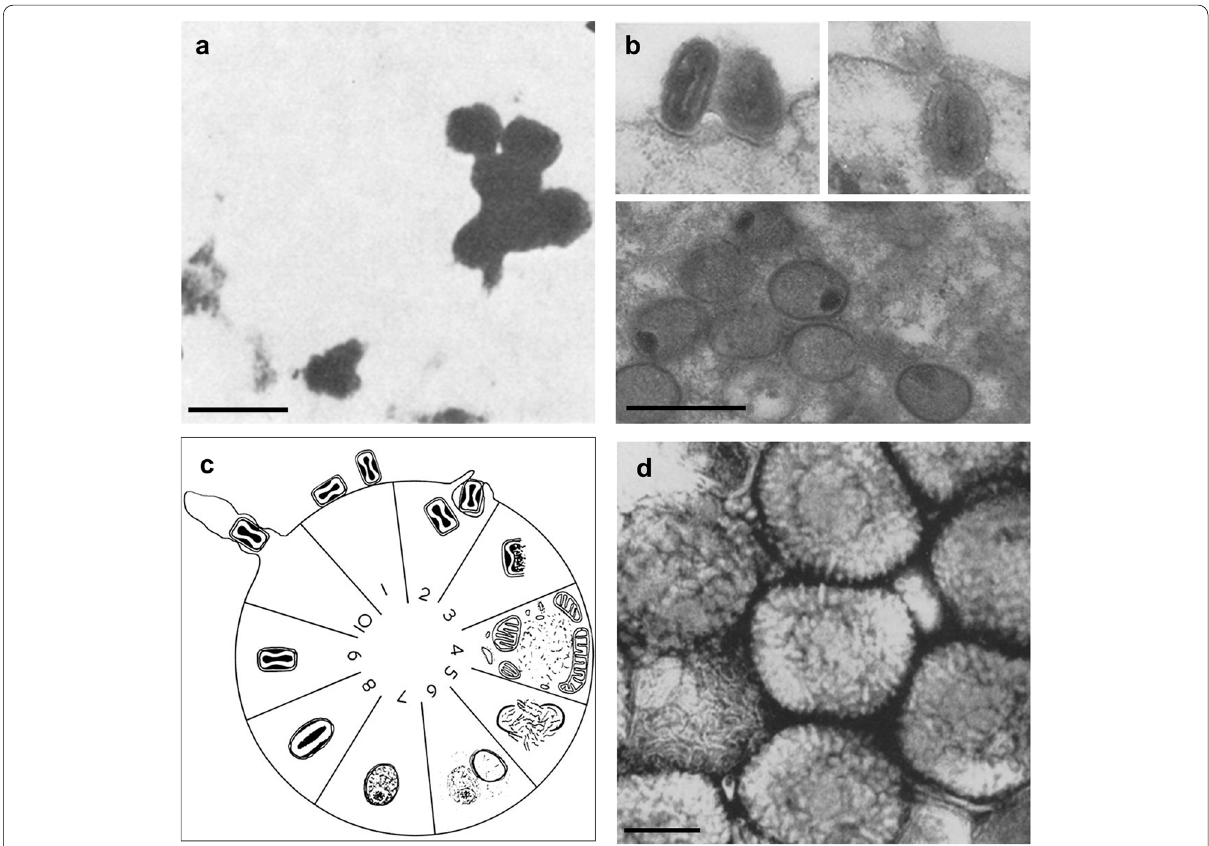
Fig. 1 Early TEM examinations of VACV and proposed virion assembly. a Brick-shaped morphology of VACV “elementary bodies” first described by Ruska in 1939. b Thin-section TEM images of VACV mature virions (top row) and immature virions containing nucleoids (bottom row). c VACV assembly cycle as proposed by Dales, showing schematic illustration of virion morphology and post-infection time in hours. d TEM image of negatively stained whole VACV mature virion exhibiting characteristic surface tubule decoration. Scale bars are 0.5 μm in ( a ) and ( b ), and 0.1 μm in ( d ). The images are reprinted with permission. Original works are from a Ruska et al., Archiv für die gesamte Virusforschung, 1939, doi: https:// doi. org/ 10. 1007/ BF012 43399, b , c Dales and Siminovitch, The Journal of Biophysical and Biochemical Cytology, 1961, doi: https:// doi. org/ 10. 1083/ jcb. 10.4. 475, d Dales, The Journal of Cell Biology, 1962, doi: https:// doi. org/ 10. 1083/ jcb. 13.2.